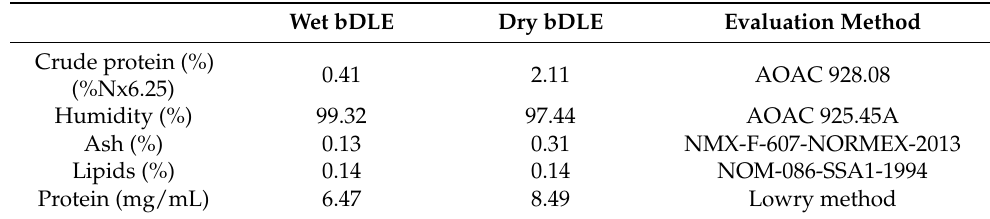
Table 1. Bromatological composition of wet and dry bovine dialyzable leukocyte extract